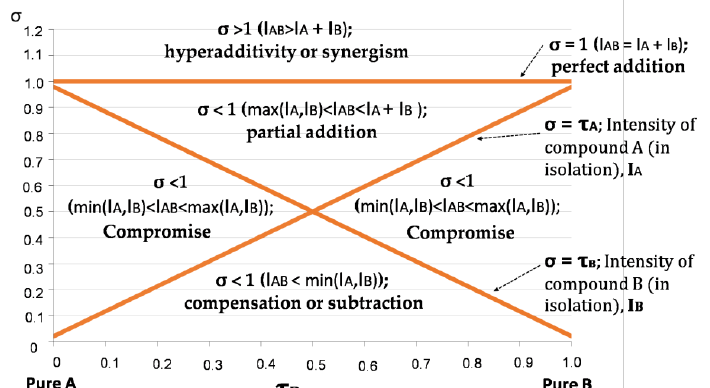
Figure 1. Plot with the representation of σ vs. τ with the most probable results according to the intensity values in the binary mixture, as proposed by Cain and Drexler [37]. Adapted with per- mission from ref.